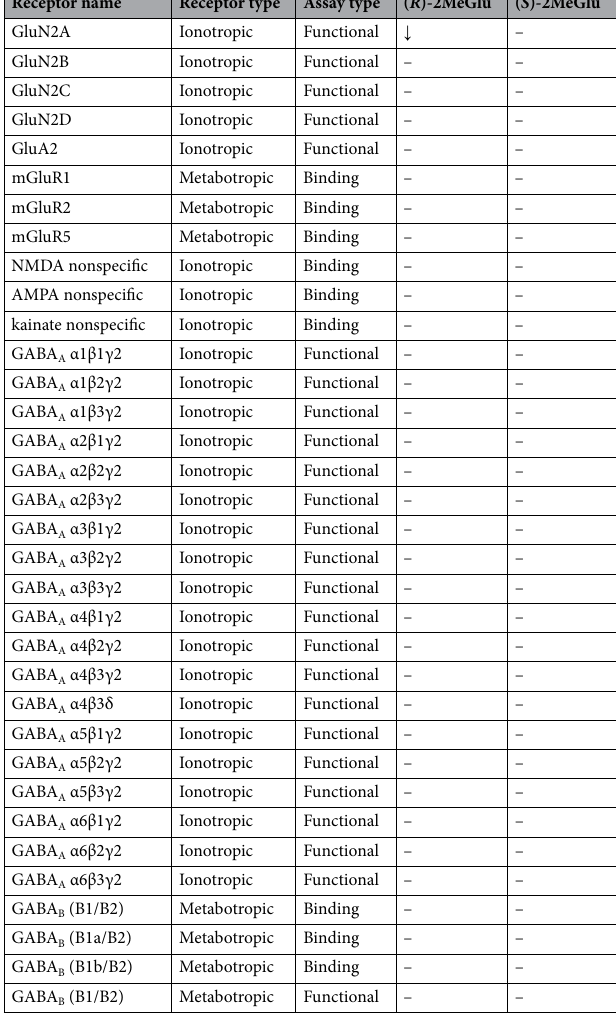
Table 1. Summary of glutamate and GABA receptor interaction assays. ‘ ↑ ’ or ‘ ↓ ’ arrows indicate agonist or antagonist activity, respectively. The number of arrows indicates IC50/EC50 in the range of 10–100 μM (one arrow), 1–10 μM (two arrows), or < 1 μM (three arrows). Interactions with EC 50 or IC 50 above 100 μM are marked as